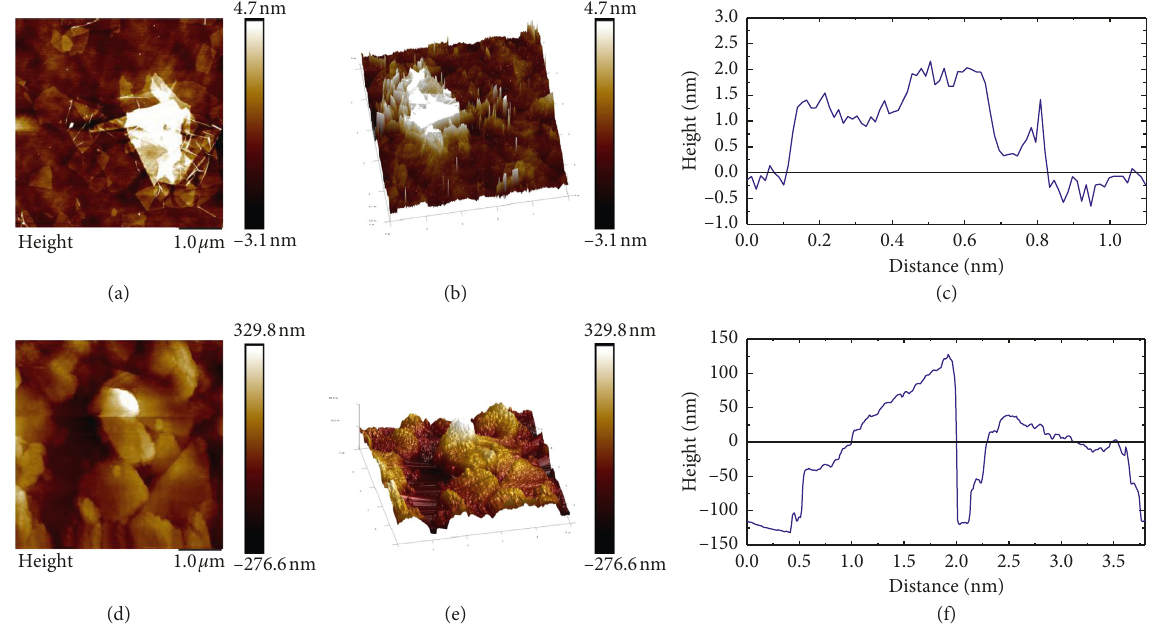
Figure 3: AFM images of (a)–(c) GO and (d)–(f) ZIF-8/GO nanosheets.